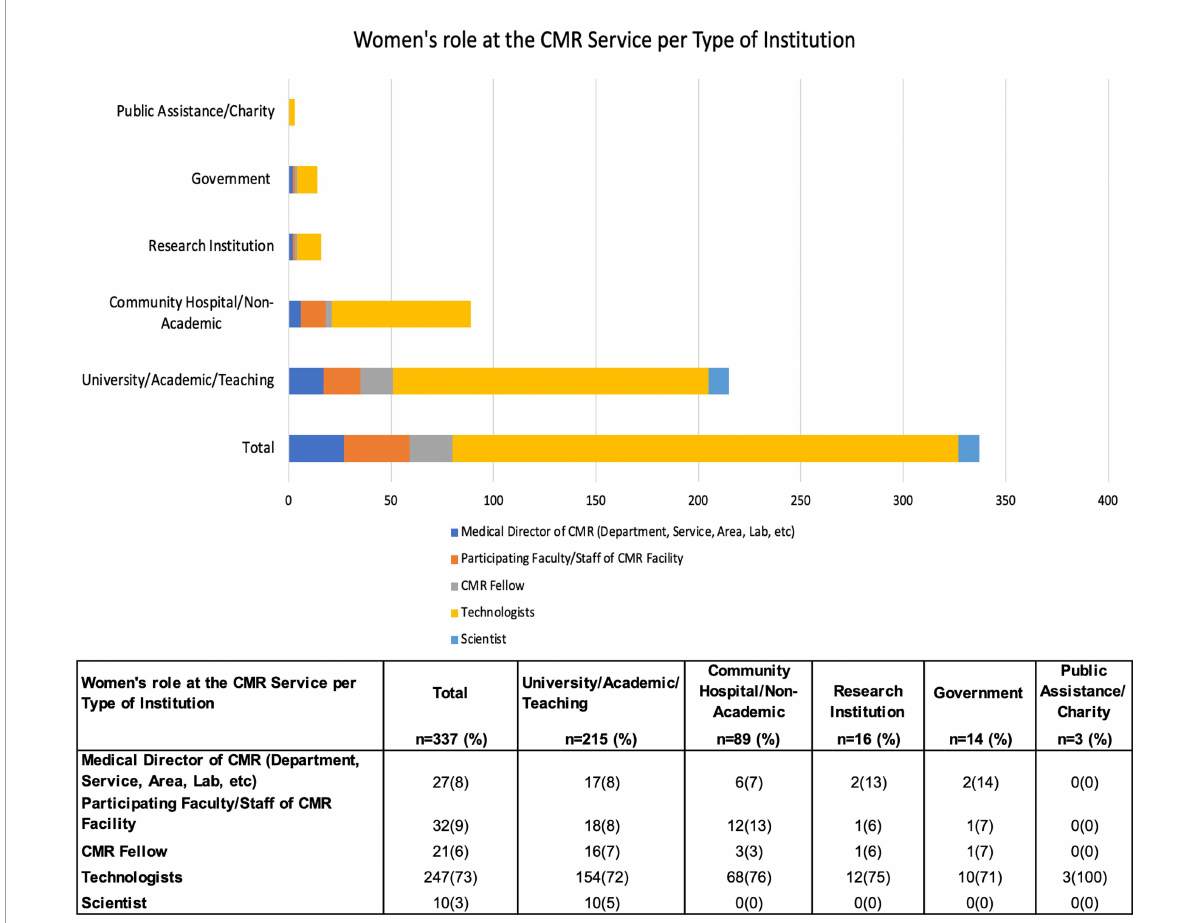
FIGURE6 Women’s role at the CMR Service per Type of Institution of the CMR survey practitioners. Responses in this category = 337. This stacked bar graph shows the women’s role at the CMR service per type of institution, where 64% practice in the university, academic, or teaching environment. Although it is where women primarily participate in leadership roles, 26% of women develop their professional activities in the community or non-academic institutions, where 76% participate as technologists. Women scientists are working only in universities or academic institutions. Detailed data shown in the graph description is in the table at the bottom of the figure.